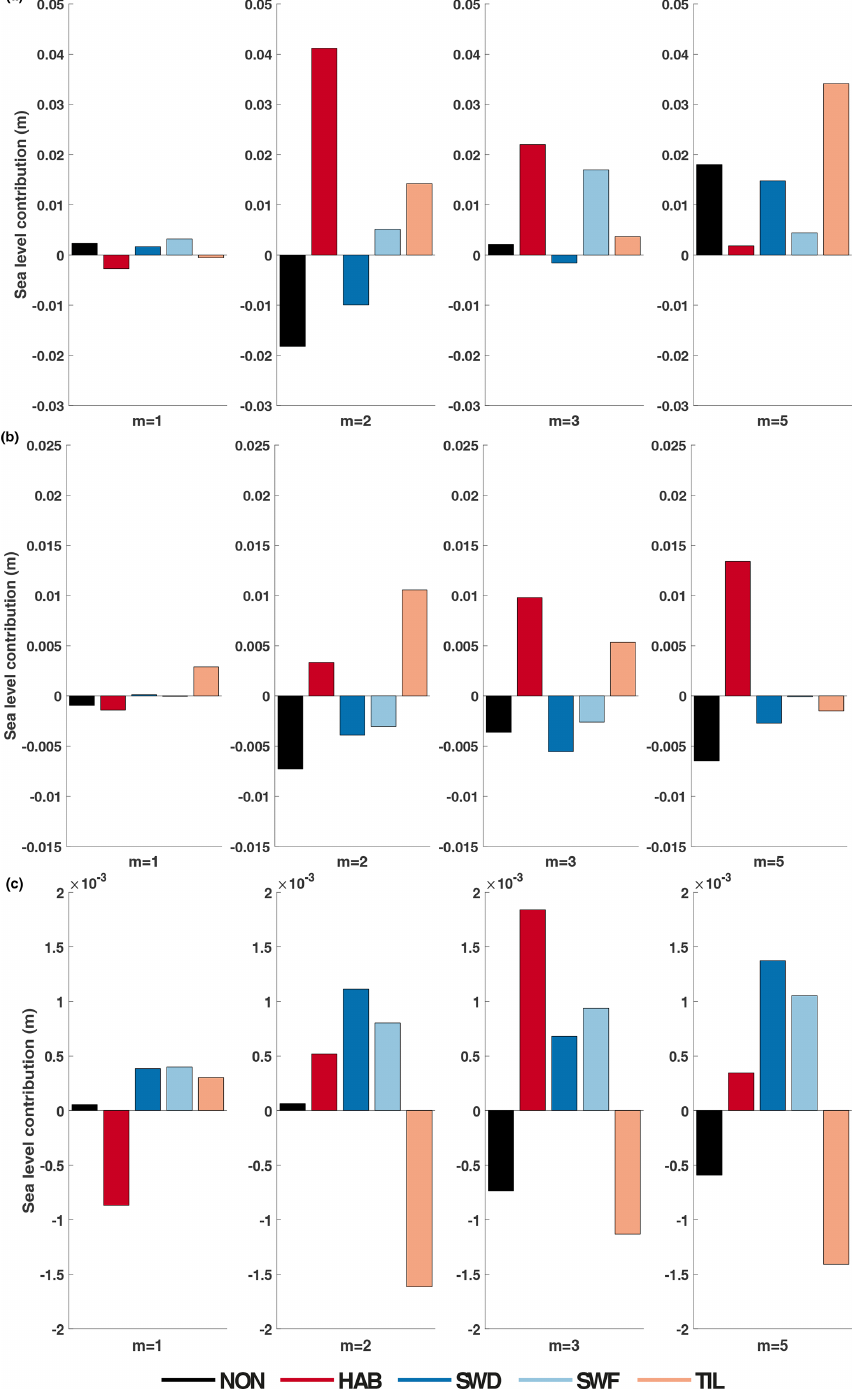
Figure 9. Sea level contribution according to HadGEM2 RCP8.5 for different basins and different values of m in the sliding law and subglacial hydrology: Pine Island and Thwaites glaciers (a) , Wilkes Land (b) , and Enderby Land (c) . Colour bars represent the different subglacial models (Table